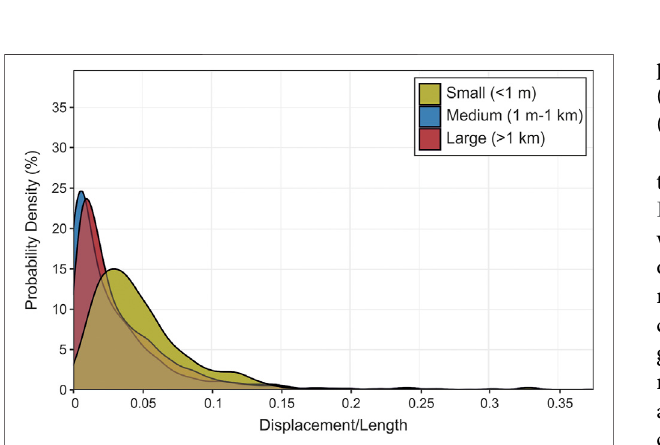
FIGURE 3 | Density estimates of the D/L value of small, medium, and large faults in our dataset. Peaks in the density plot are at the D/L values with the highest